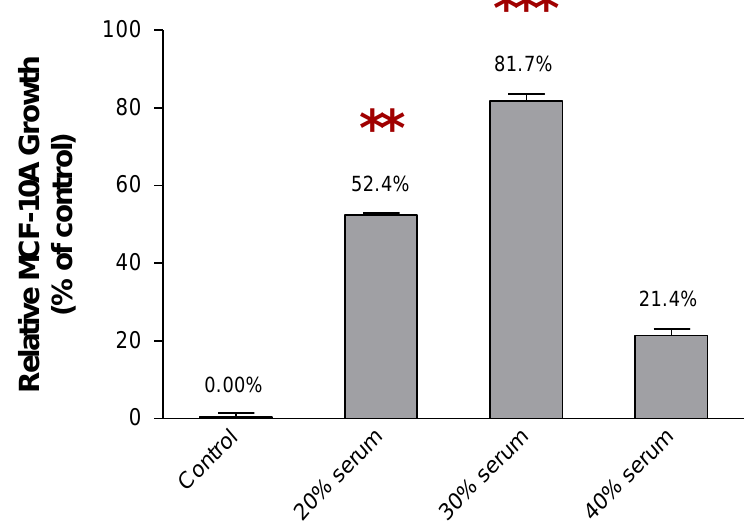
Figure 3. Growth of MCF-10A cells incubated with increasing concentrations of serum in the growth medium. One thousand cells were used as the input for incubation, and the incubation was carried out for 1 week. Each value was calculated as the % of incubated cells when compared to control cells. The values were expressed as mean ± SD from 3 replicates. ** p < 0.01 and *** p < 0.001 were denoted as statistically